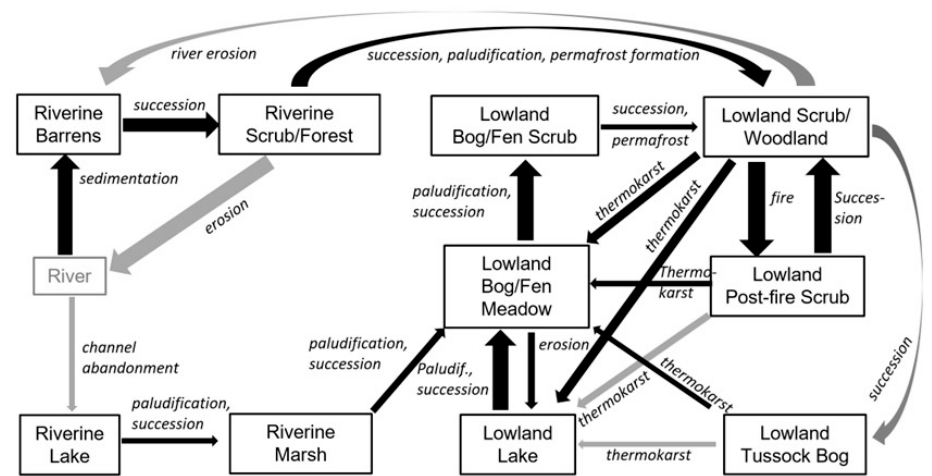
Figure 14. Schematic of ecological transitions during the Mid-to-Late Holocene that contribute to landscape evolution. The boxes indicate ecological states (ecotypes) and the arrows indicate transitions and processes. Black arrows indicate transitions observed through remote sensing, soil paleo-ecological indicators, or transect surveys, while gray arrows indicate transitions documented by [55]. The size of the arrows are roughly proportional to frequency of occurrence.